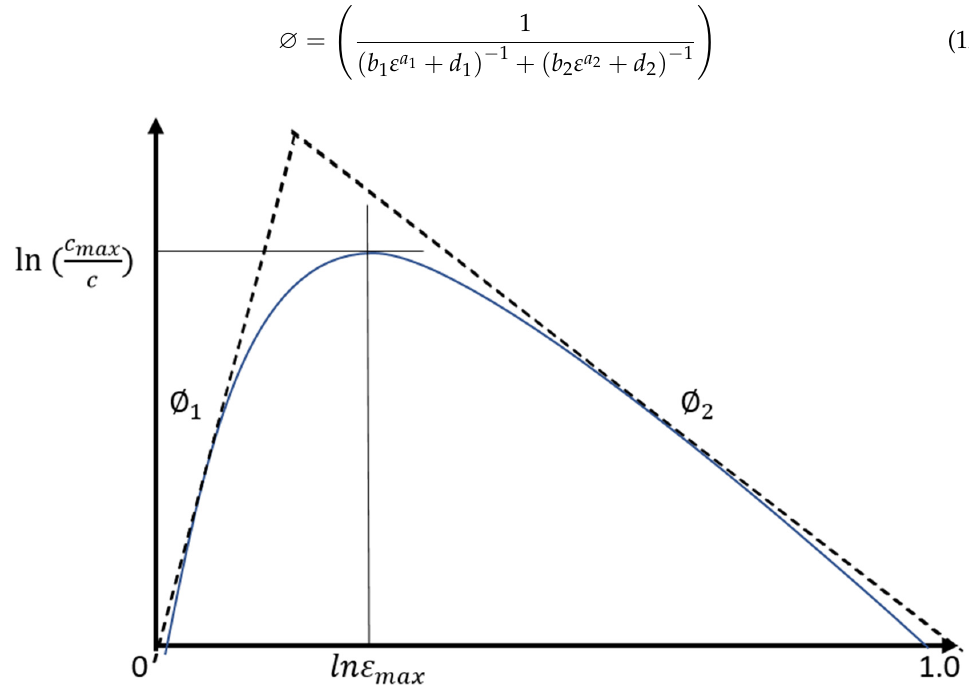
Figure 3. Schematic of the asymptotic matching method.